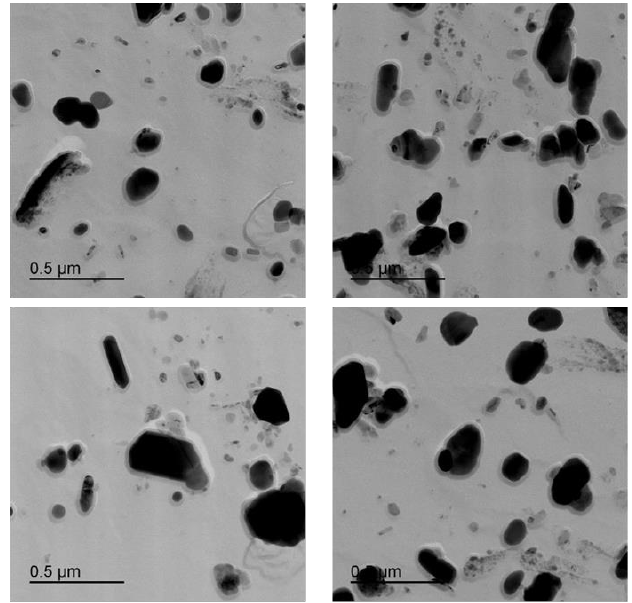
Figure 16. Grade 92 in ex-service exposed 92-EX-1-2 604 ◦ C 40 MPa 74,001 h. TEM images on a carbon extraction replica at 50,000X.